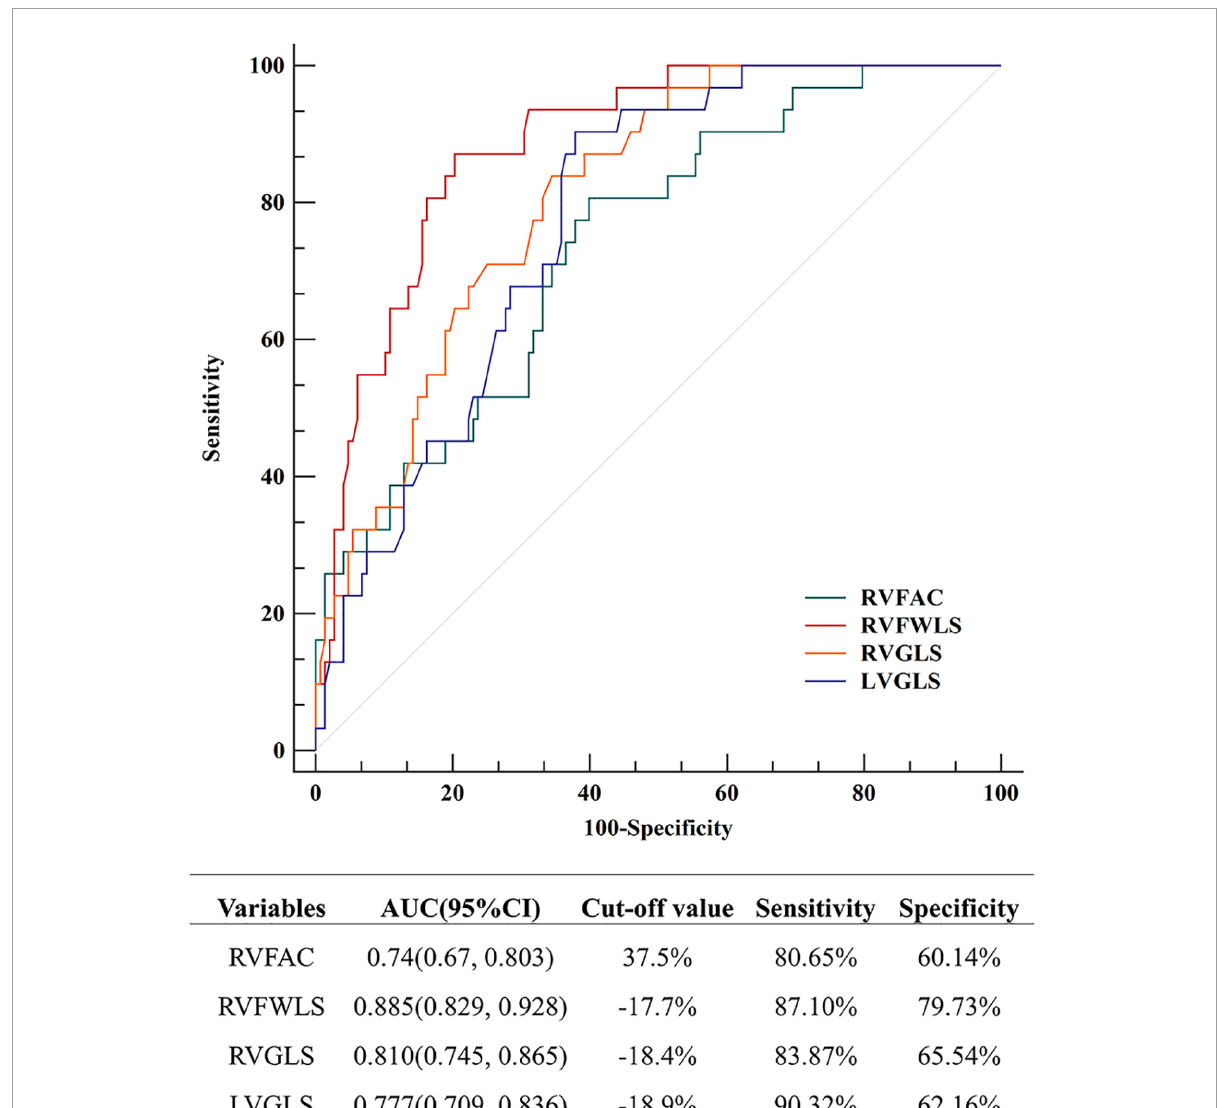
FIGURE2 Receiver operator characteristic (ROC) analysis for prediction of adverse events in patients with r-TOF; ROC, receiver operating